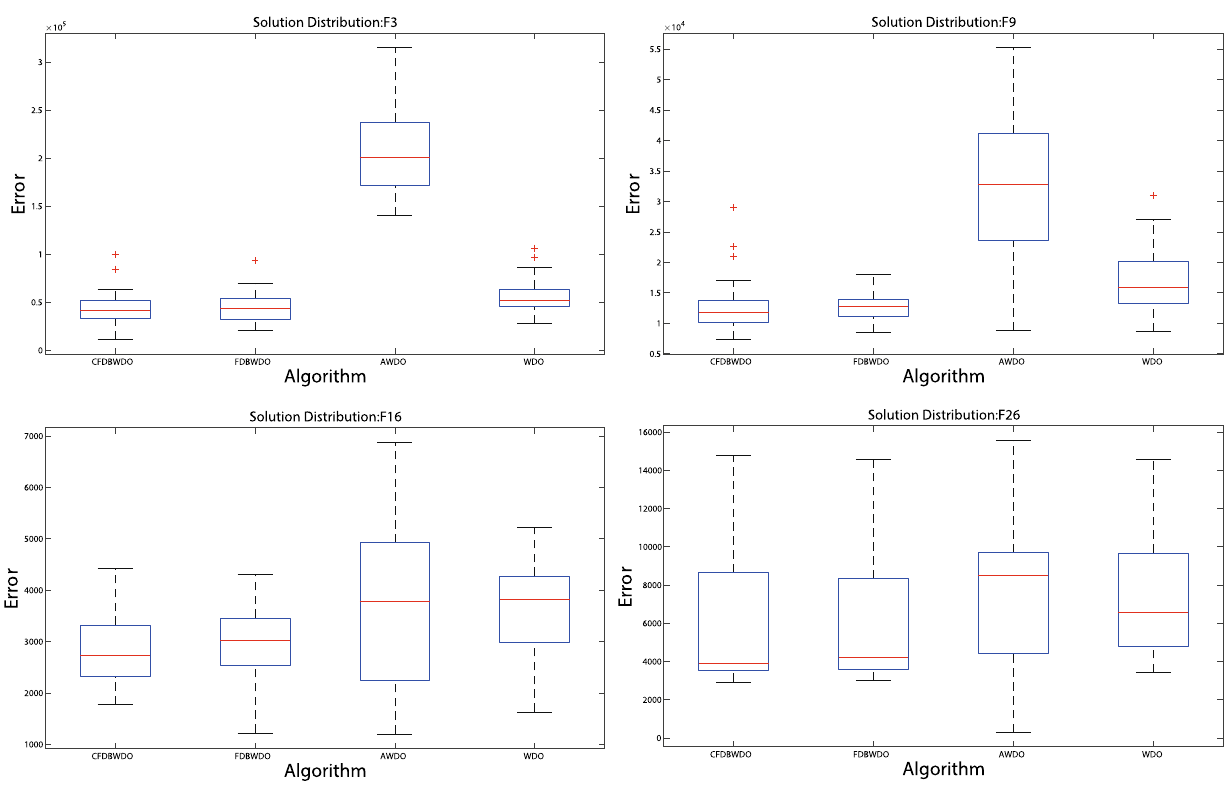
Fig. 7 Box-and-whisker diagrams of four WDO variants on F3, F9, F16 and F26 with 50